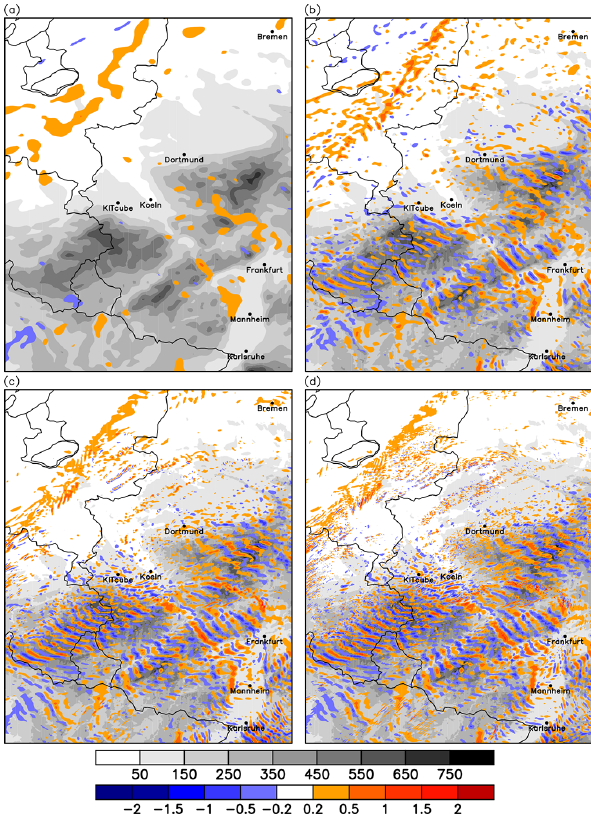
Figure 5. 10m wind convergence (shading in 10 − 3 s − 1 ) on 15 April 2013 at 16:00UTC for (a) 2.8km, (b) 1km with 1-D tur- bulence, (c) 500m, and (d) 250m grid